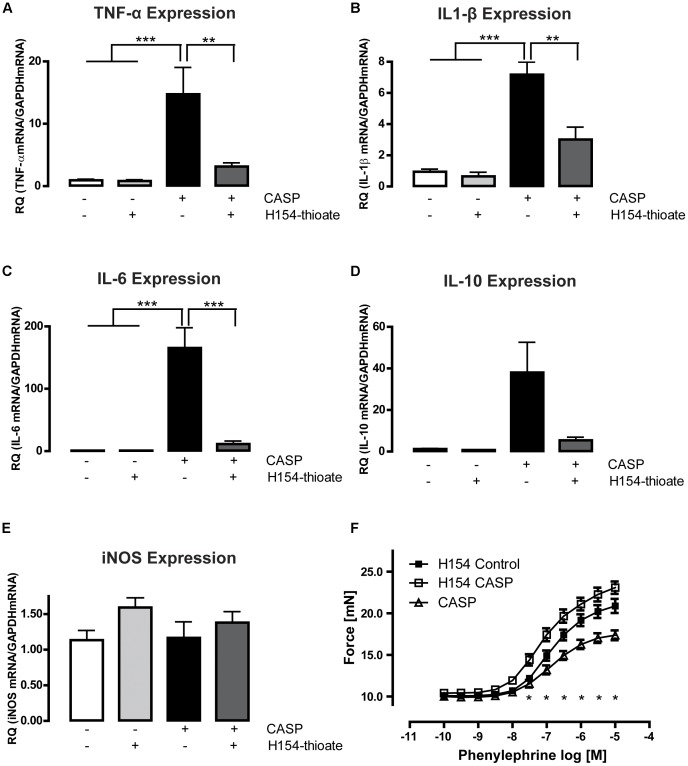
Prevention of CASP induced aortic cytokine and iNOS production following TLR9 antagonist treatment.
A-E 24 h of exposure to the synthetic TLR9 antagonist H154-thioate did not induce mRNA expression of the investigated cytokines, but prevented the CASP-dependent rise in mRNA expression of inflammatory mediators. There was no observable influence of H154-thioate on iNOS expression. F H154-thioate treatment prior to CASP completely prevented the CASP-induced arterial hypocontractility observed in WT animals (F) (*p<0.05; **p<0.01; ***p<0.001; n≥5 animals in each group; mean ± SEM).